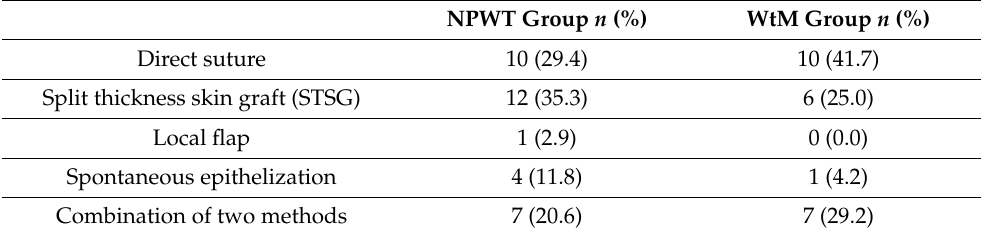
Table 4. Modality of definitive wound